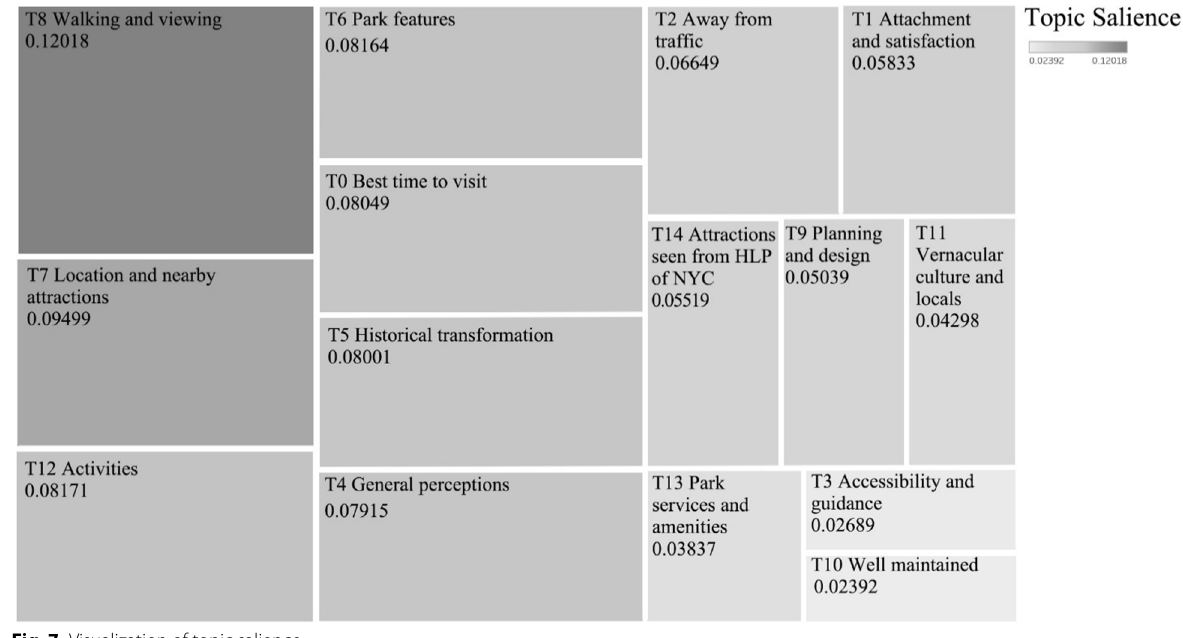
Fig. 7 Visualization of topic salience